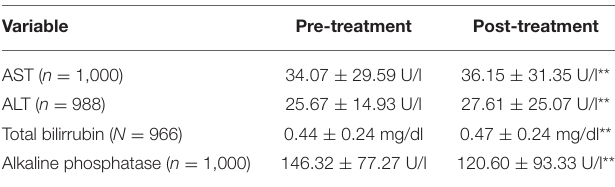
TABLE 3 | Hepatic safety